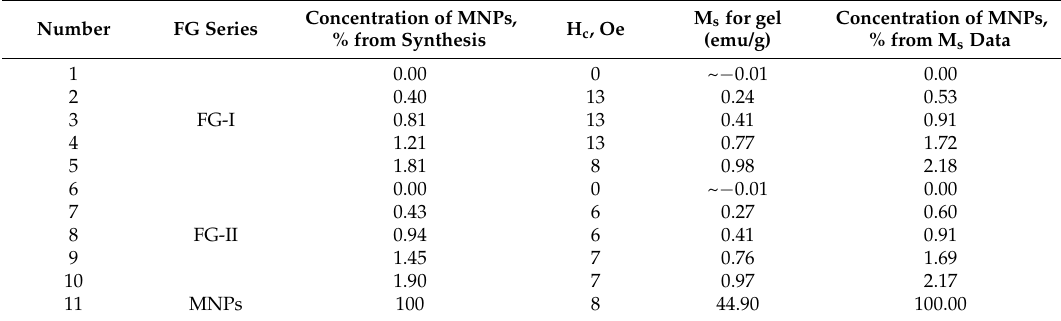
Figure 6. M(H) hysteresis loops of soft ( a ) and of dense ferrogels ( b ): in both cases concentrations of magnetic filler are obtained from the synthesis data. Inset for ( a ) shows the hysteresis loop of iron oxide MNPs from dried ferrofluid. Inset for ( b ) shows the hysteresis loop of pure gel. Concentration dependence of the saturation magnetization for soft and dense gels with different amount of magnetic filler ( c ). Parts of M(H) hysteresis loops of soft ( d ) and of dense ferrogels ( e ) approaching remanence: in both cases concentrations of magnetic filler are given for magnetic measurements data. Vertical bars indicate the field interval of 4 to 11 Oe corresponding to typical anisotropy fields of thin magnetic films used in sensor applications. Table 2. Magnetic properties of MNPs, gels and ferrogels: H c is coercivity; M s = M(H = 10 kOe).